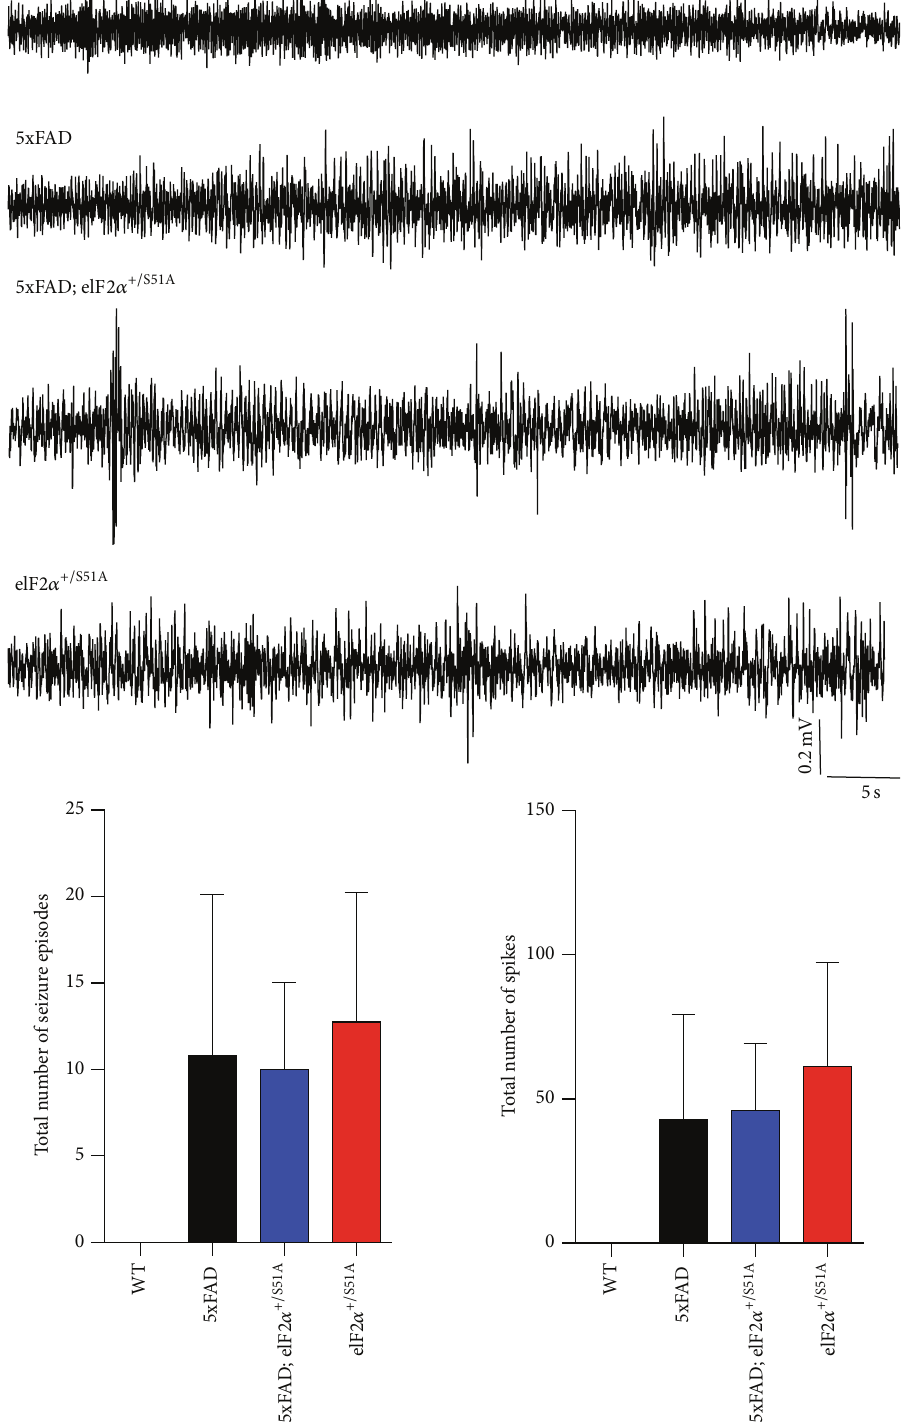
Figure 3: EEG recordings revealed nonconvulsive seizure activity in the motor cortex of animals carrying the 5xFAD transgenes and/or the 𝑒𝐼𝐹2𝛼 +/ S 51 A allele. Radiotelemetric recordings from the primary motor cortex (M1) of wild-type, 5xFAD, 5xFAD; 𝑒𝐼𝐹2𝛼 +/ S 51 A , and 𝑒𝐼𝐹2𝛼 +/ S 51 A mice (WT, 𝑛 = 4 mice; 5xFAD, 𝑛 = 6 mice; 5xFAD; 𝑒𝐼𝐹2𝛼 S 51 A , 𝑛 = 3 mice; 𝑒𝐼𝐹2𝛼 S 51 A , 𝑛 = 4 mice). Wild-type mice did not exhibit seizure activity, whereas all other genotypes showed episodes of spike, polyspike, and spike-wave activity. Shown are example traces, as well as a quantification of the number of seizure episodes and the number of spikes, respectively. Bar graphs show mean ±